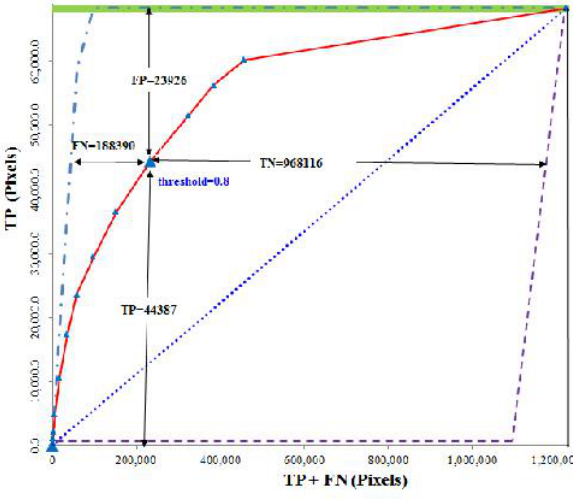
Figure 5. Total operating characteristic (TOC) for the performance of RFR in simulating urban change between 2000